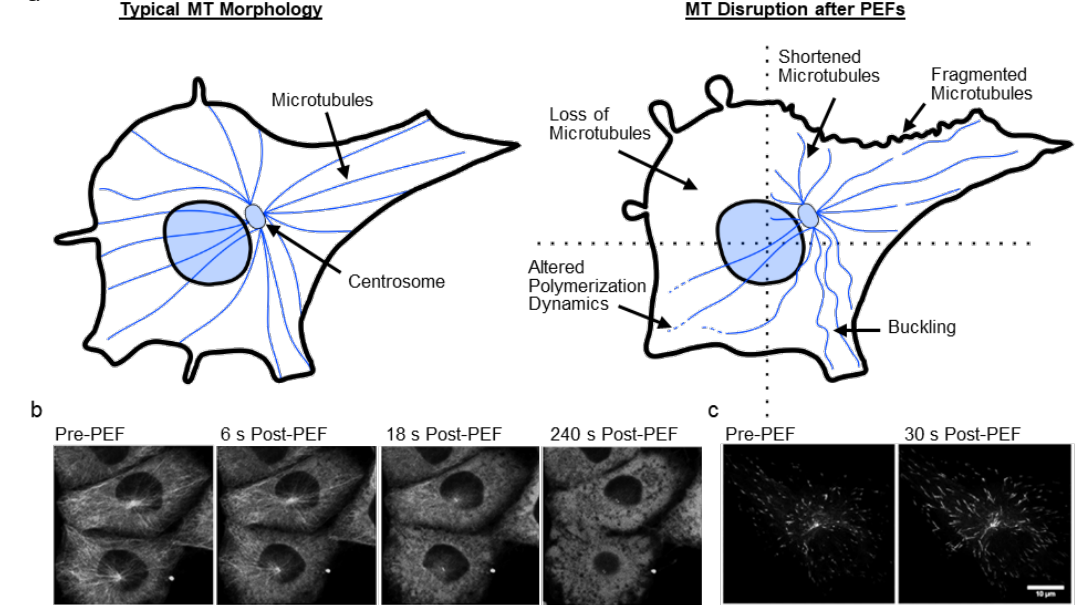
Figure 3. PEF-induced microtubule (MT) disruption. ( a ) MTs nucleate from the centrosome in mammals, and radiate (polymerize) outward under normal conditions (left). After PEFs, MTs may show buckling, fragmenting, altered growth, or be depolymerized (right). ( b ) Chinese hamster ovary (CHO-K1) cells show depolymerization of MTs after 600 ns PEFs in calcium-containing media. Adapted from [75]. ( c ) MT end-tracking protein EB3 demonstrates altered MT dynamics in human glioblastoma (U-87 MG) cells after 10 ns PEFs. Both the rate of polymerization and the number of polymerizing MTs change. Adapted from [47] .